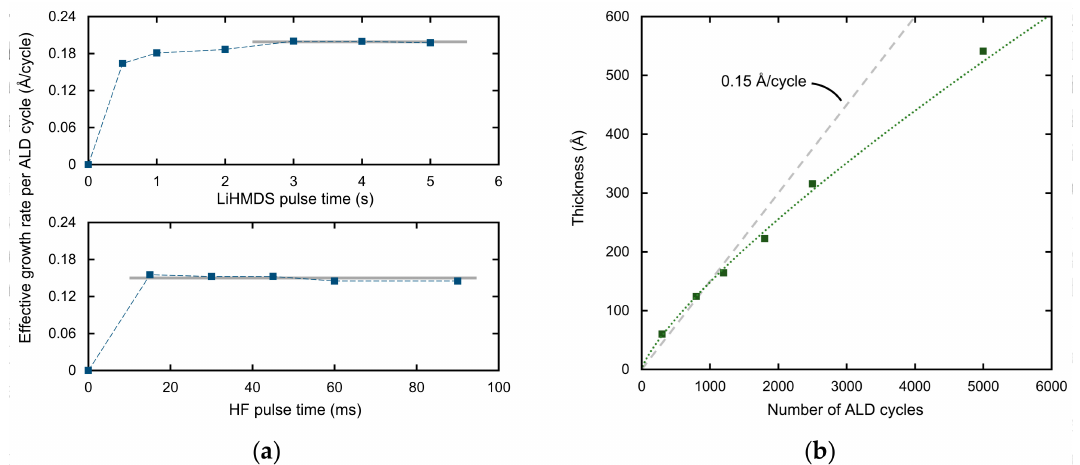
Figure 1. ( a ) The dependence of ALD deposition rate on LiHMDS and HF exposure time. The LiHMDS experiments were performed for 300 ALD cycles for each data point; the HF experiments used 600 ALD cycles; ( b ) The measured film thickness versus number of ALD cycles, which indicated a degradation in linearity for films deposited at a substrate temperature of 150 ◦ C.